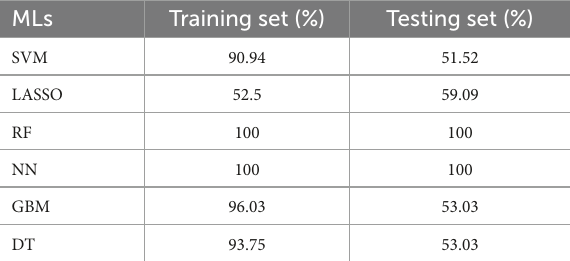
TABLE 2 The accuracy of six classification machine learnings (MLs) in the training and testing sets.